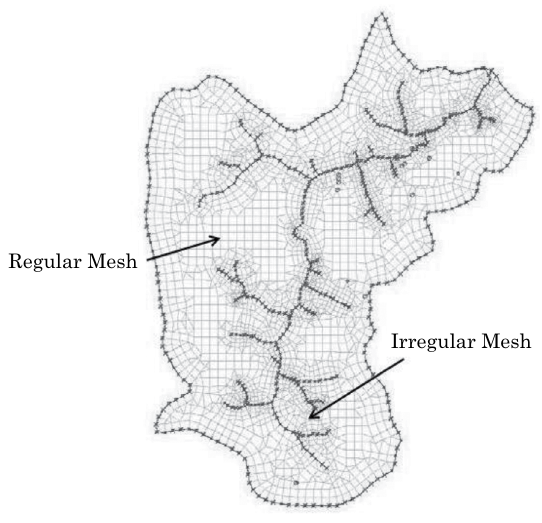
figure 3. discretization of the model domain in a finite element mesh.